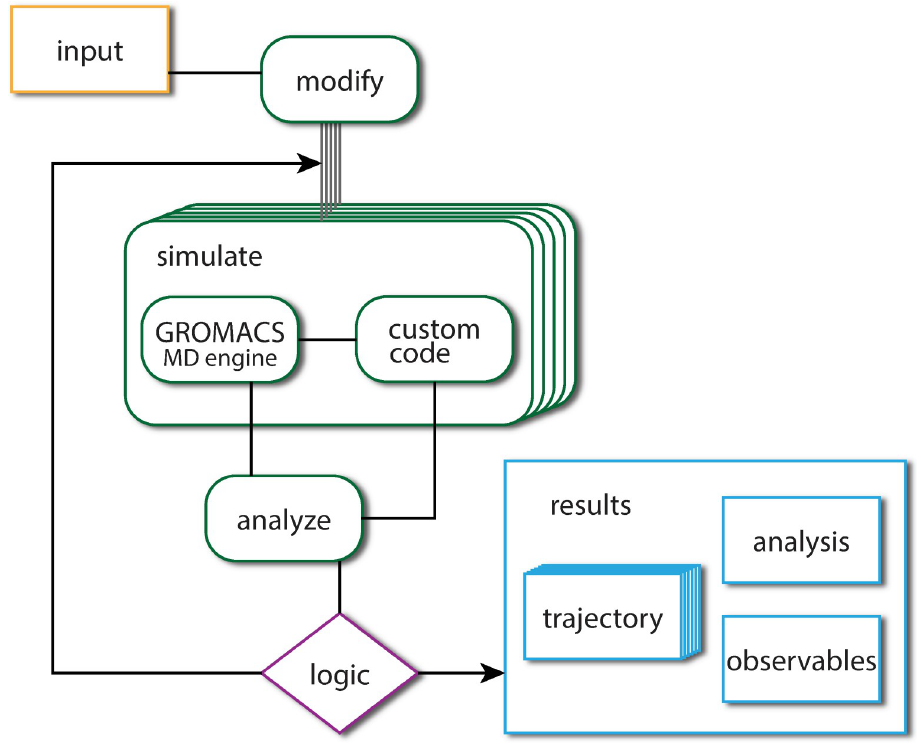
Fig 2. Schematic of data flow and control flow for a segment of a complex simulation workflow. Ensembles of simulations can be run (denoted by stacked rectangles) by gmxapi merely by passing an array of inputs instead of a single input. Custom plugins can interact with running MD simulations. Finally, conditional and looping logic can create high-level simulation